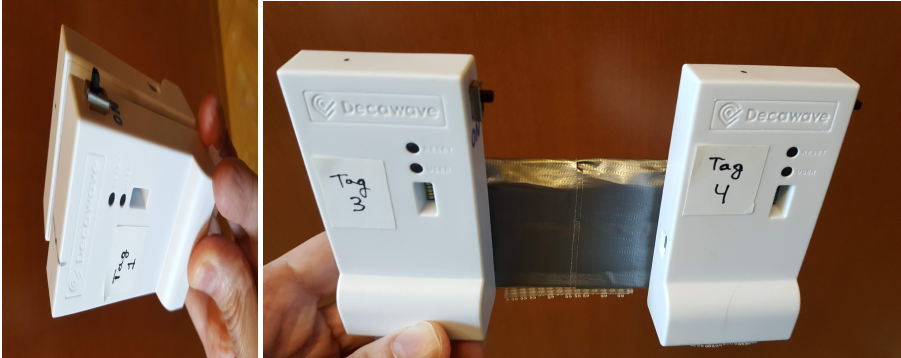
Figure 7. Pairing of tags: Close pairing ( left ) and Far-pairing ( right